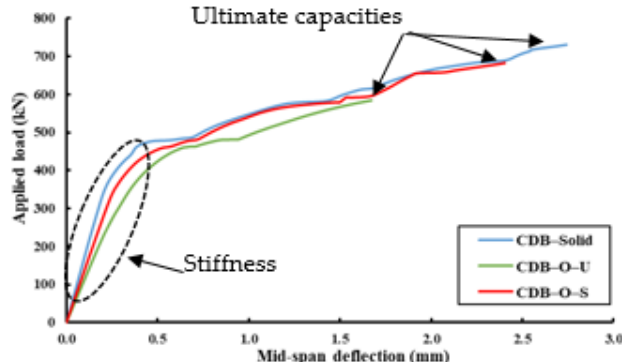
Figure 7. Load mid-span deflection curves for the tested specimens.